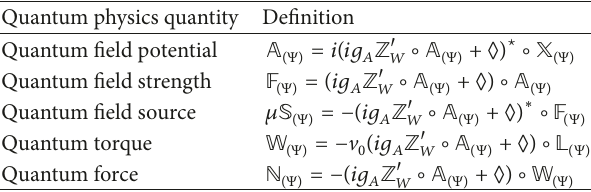
Table 6: Some field equations of the non-Abelian gauge field in the complex-sedenion quantum mechanics, when the term Z 𝑊 ∘ W ⋆ /(ℏ V ) can be reduced into the term 𝑔 0 of the electromagnetic quantum-field, these field equations can be degenerated into the Yang-Mills equations for the electroweak